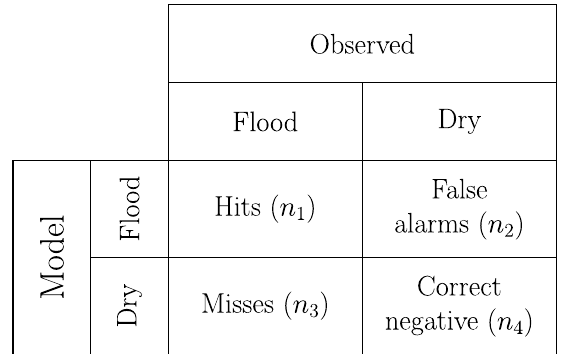
Figure 8. Contingency table gathering the different scenarios en- countered during calibration (the numbers refer to